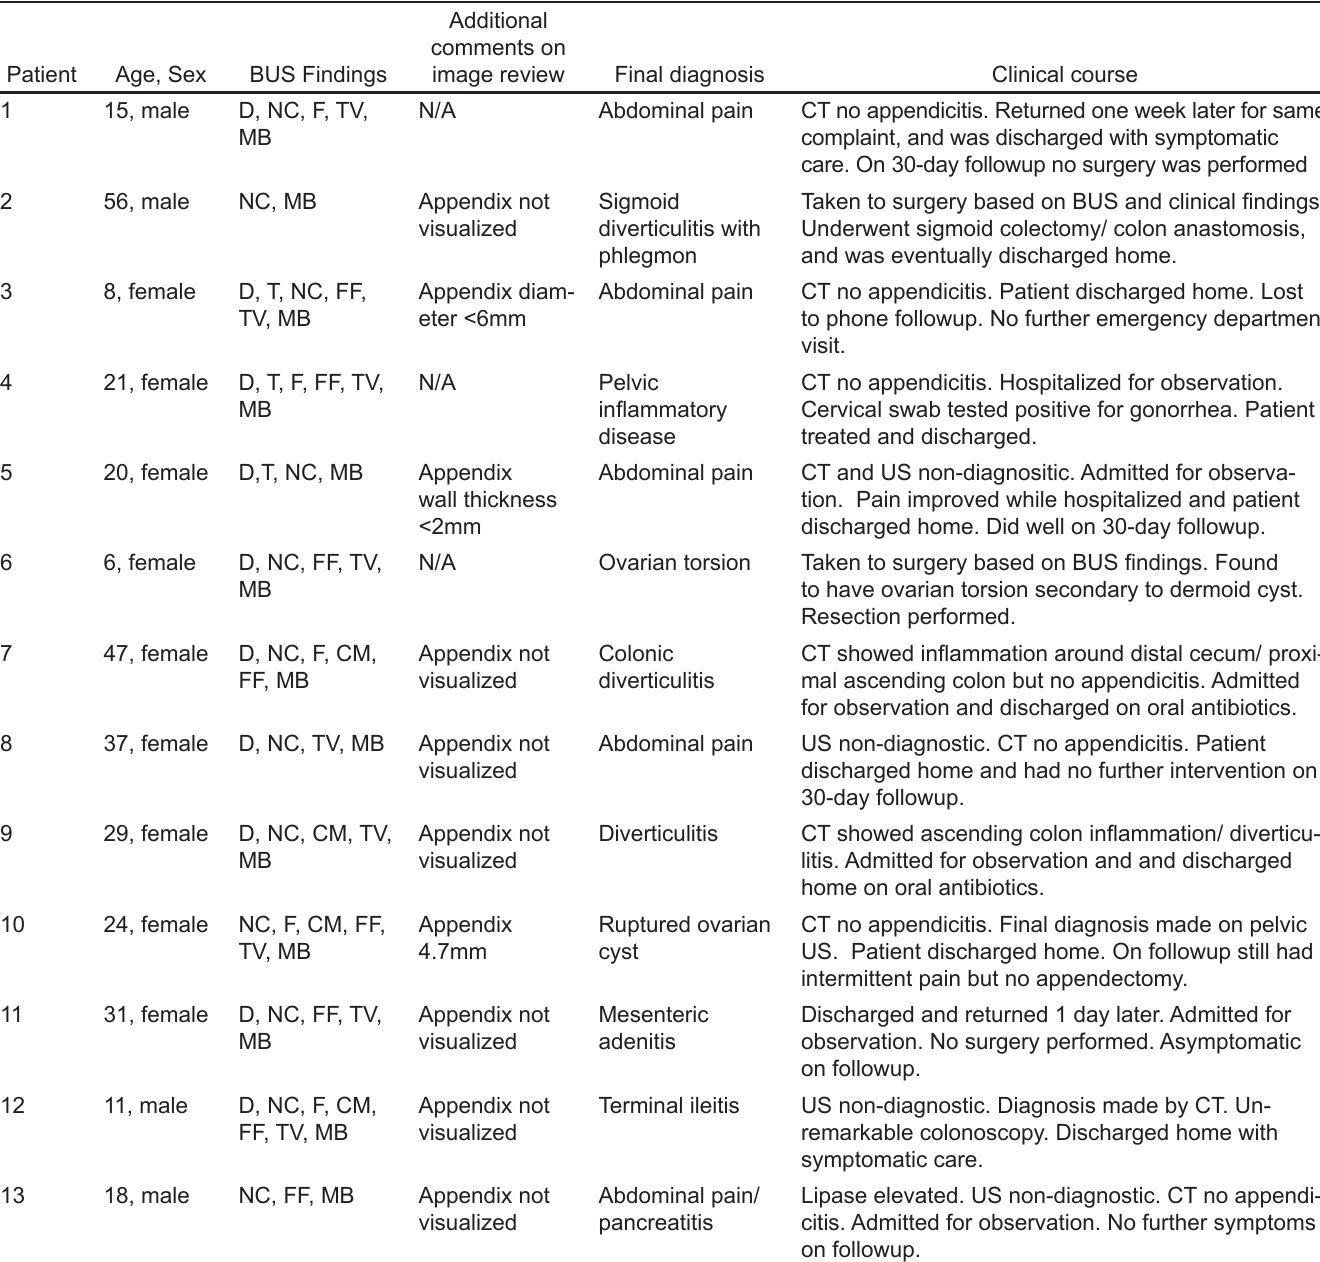
Table 3. Bedside ultrasound (BUS) findings, final diagnoses, image review comments, and clinical course of false positive